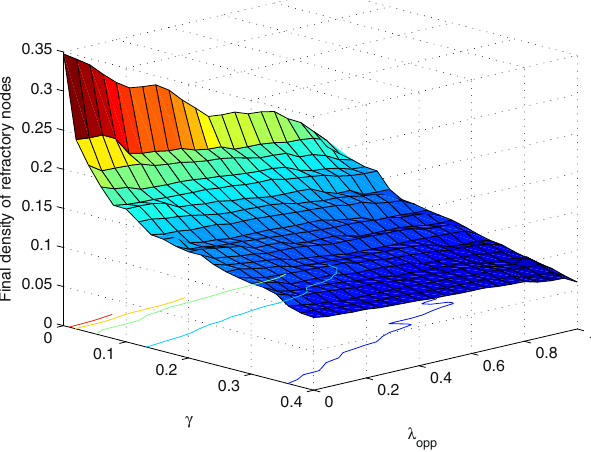
Figure 11. Final density of refractory nodes for information l 1 versus γ and λ opp when the methods of blocking nodes and propagating opposite information are included. λ = 0.2, δ = 0.2 and T =